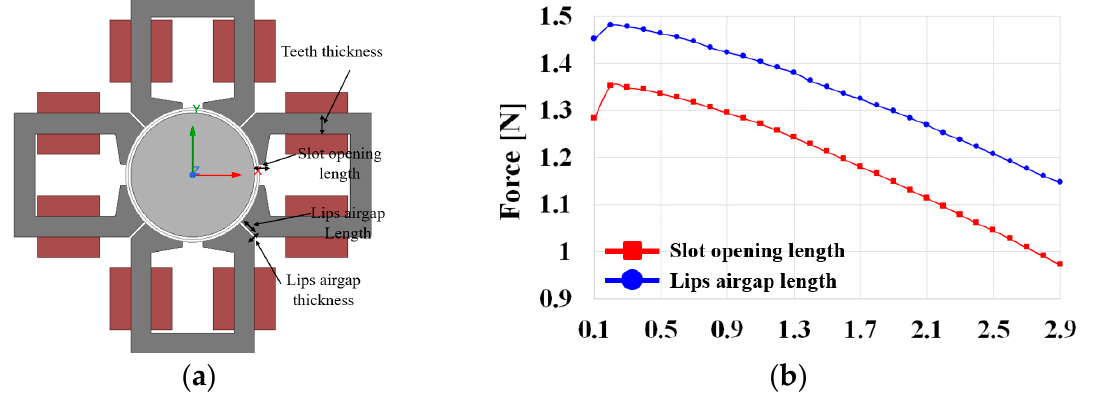
Figure 5. STMB main variable and force according to length: ( a ) STMB main variable and ( b ) force according to main variable length.